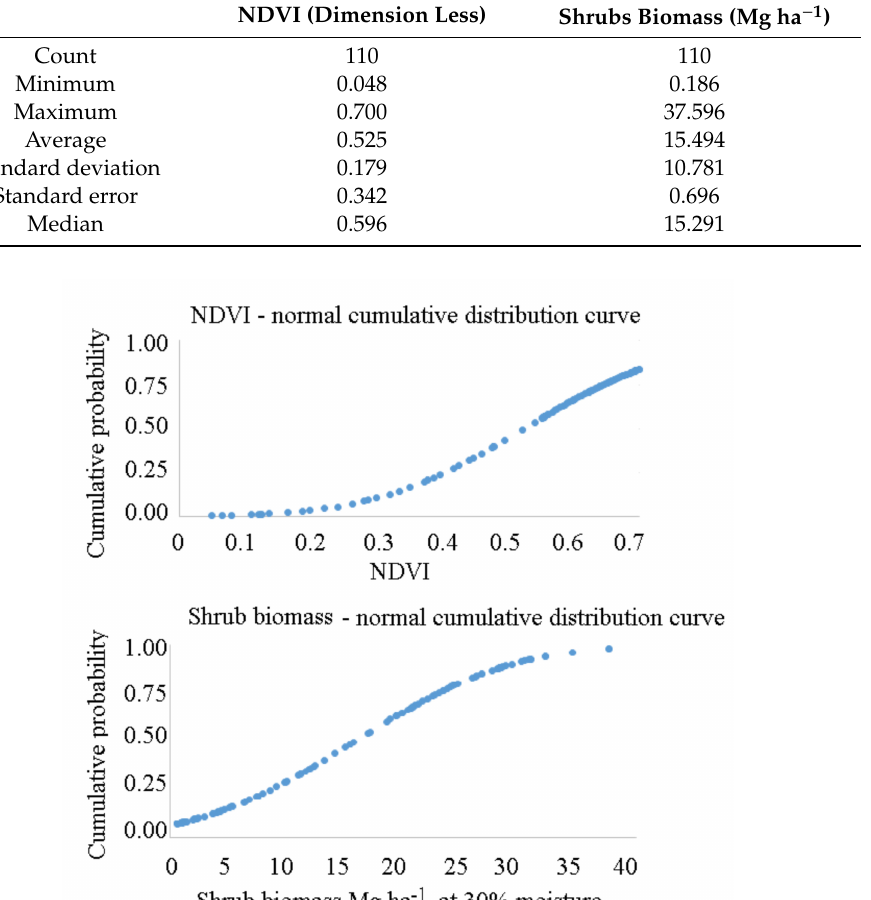
Figure 6. Normal cumulative curves to NDVI (top) and to shrubs biomass